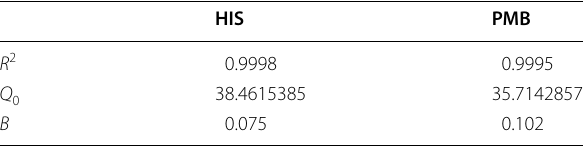
Table 4 Langmuir model